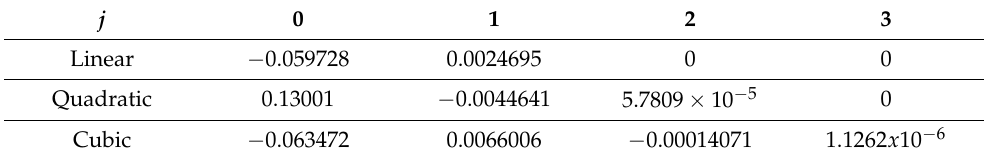
Table 5. Polynomial function coefficients for calculating k 1 .